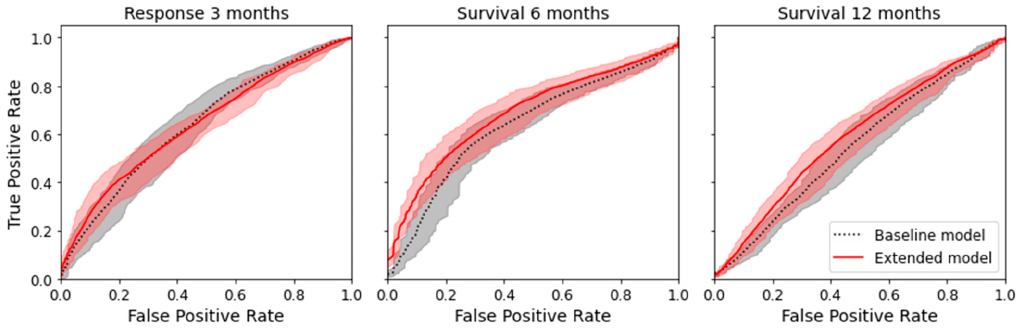
Figure 4. Mean ROC curves with 95% confidence interval for the true positive rate computed by bootstrapping the 10 × 5-fold CV.